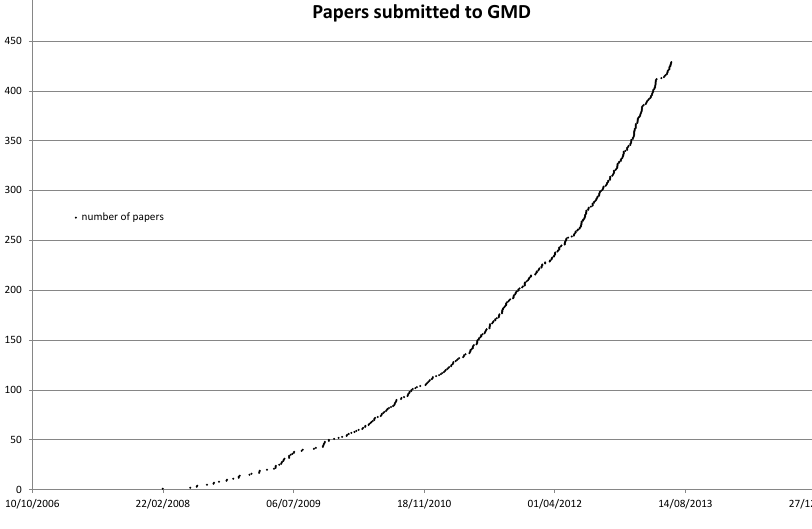
Fig. 1. The total number of submissions received by GMD since the first submission, as of 24 June